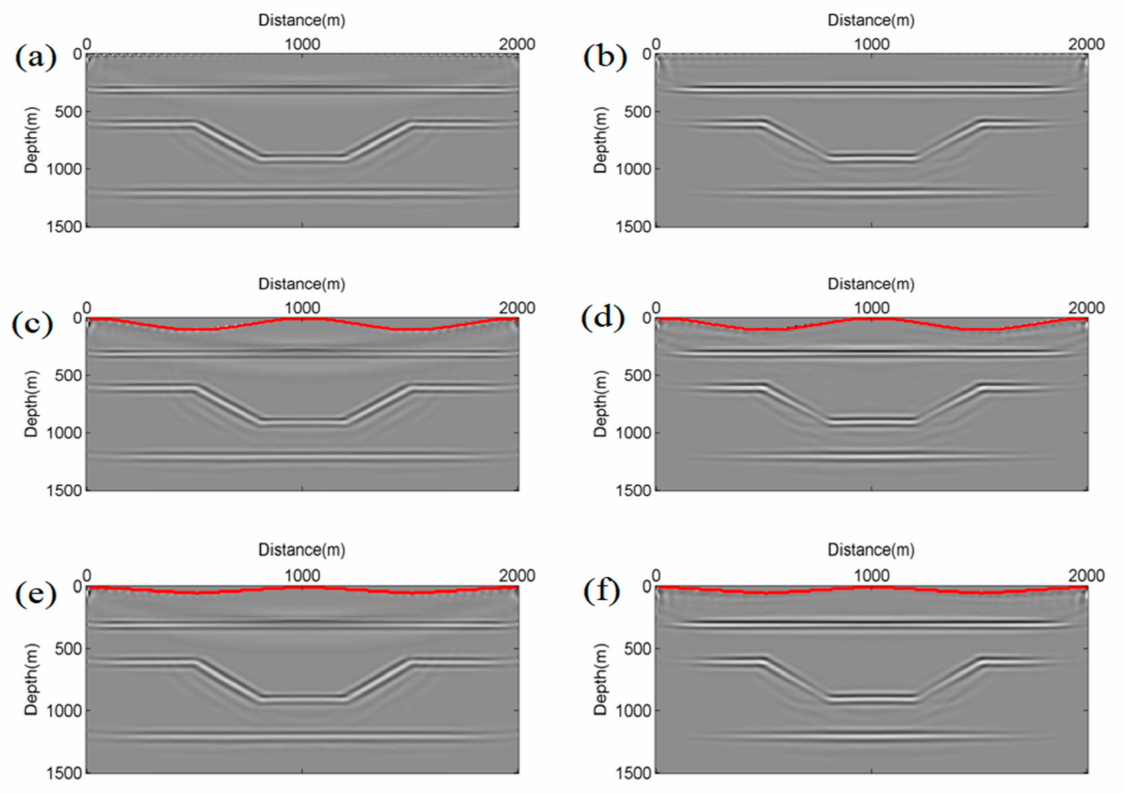
Figure 11. Migration images for graben elastic models with different topographies by the proposed method. The left panels are the PP-wave images, and the right panels are the PS-wave images. Panels ( a , b ) are the migration images for graben elastic model with a horizontal topography, panels ( c , d ) are the migration images for graben elastic model with a sinusoidal topography, and panels ( e , f ) are the migration images for graben elastic model with a triangular topography. The red line is the surface